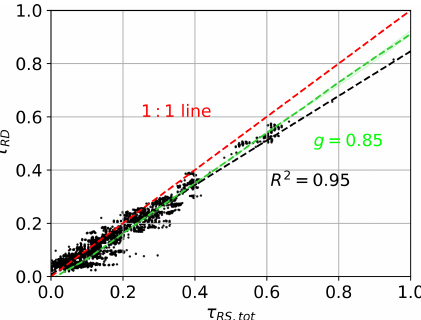
Figure 7. Aggregated optical depth data from ORACLES campaign τ RS,tot vs. τ RD . Regression gives R 2 = 0 . 95, slope = 0 . 84, and in- tercept = 7 . 9 × 10 − 3 . The green line is the predicted τ RD for a given τ RS,tot value, which is determined by RTM simulations (i.e., the dashed red line in the center panel of Fig. 3), for g = 0 .